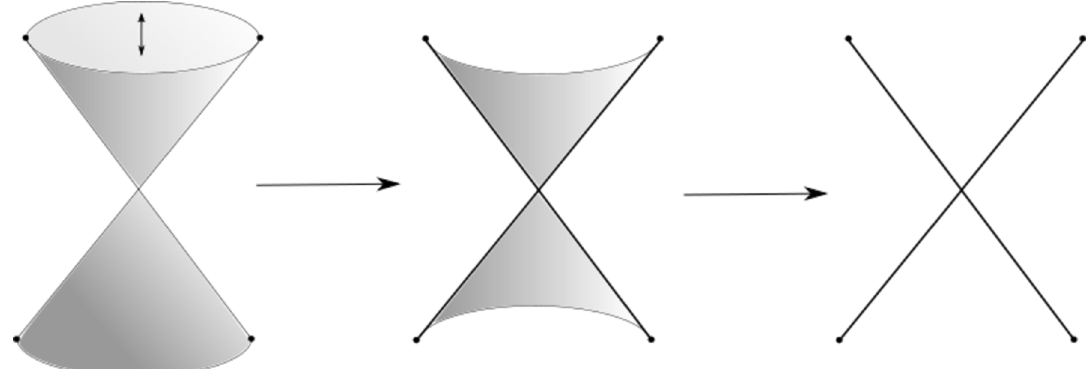
Figure 2 . (left) Initial Coulomb branch with highlighted Z 2 symmetry. (middle) Coulomb branch of the discretely gauged quiver depicted as an orbifold of the original space. Note that bold edges form a singular subspace under the Z 2 symmetry. (right) Coulomb branch of the folded quiver, the subspace fixed under the Z 2